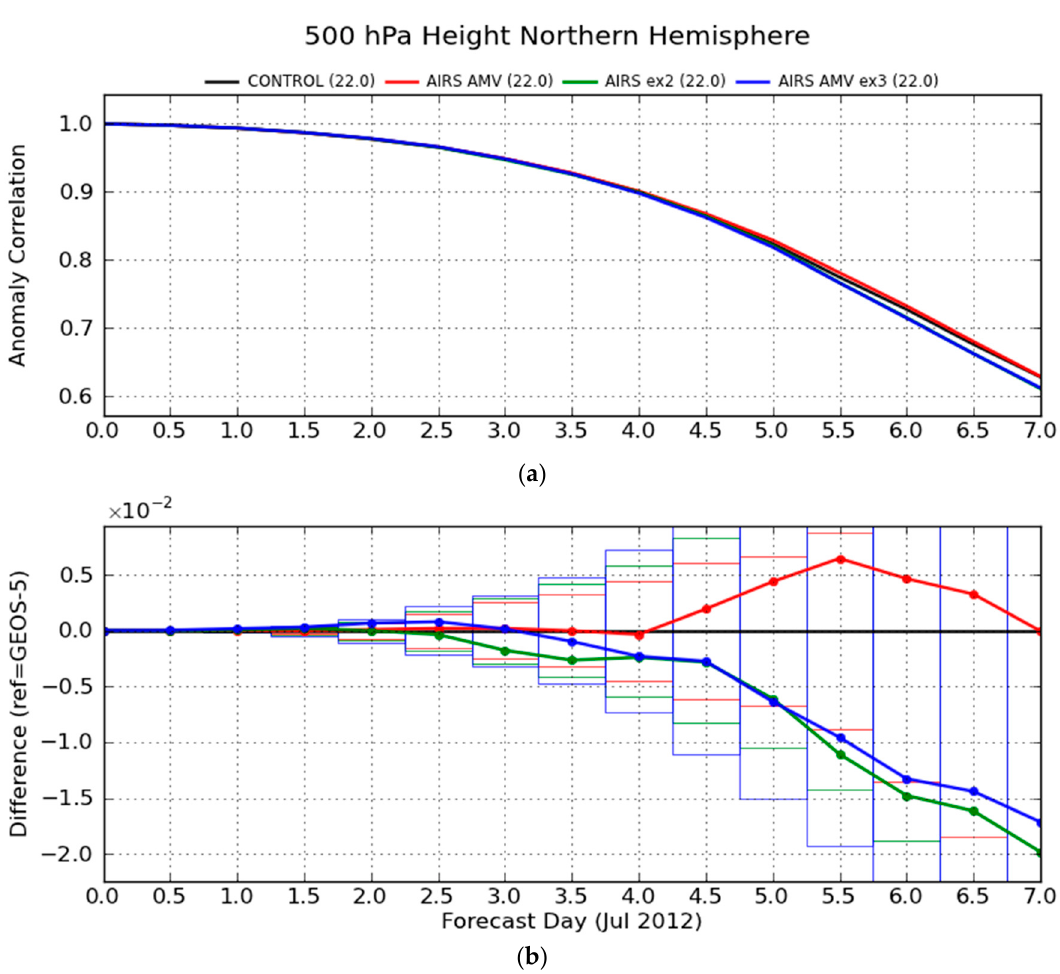
Figure 13. The 500 hPa Northern Hemisphere ACC die-off curves ( a ) for 1–24 July 2012 00 UTC. The control (black) and three experiments (red, green, and blue) are shown. The lower figure ( b ) shows the difference between the control and the experiments. A positive difference is an improvement in the forecast; to be statistically significant, the curve must lie outside of its threshold rectangle.